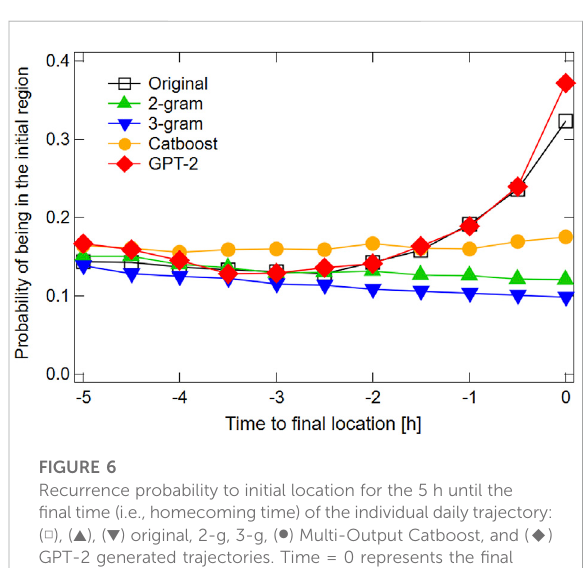
FIGURE 5 Relationshipbetweenhourlymovingdistanceandnextmovinganglefor( □ )originaltrajectoryandtrajectoriesgeneratedby( ▲ )2-g,( ▼ )3-g,( Multi-Output Catboost, and ( A ) GPT-2 models. Vertical axis is the conditional mean of the cosine between two consecutive one-hour moves. Dashed line represents a moving distance of 10 km.